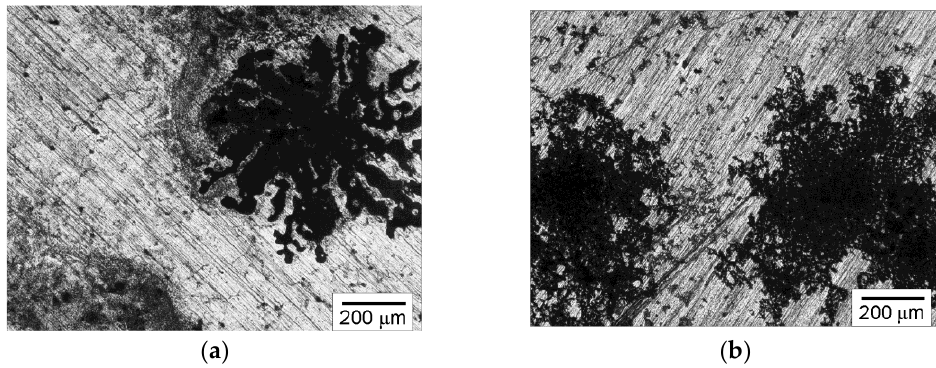
Figure 6. Corrosion centers on non-remelted ( a ) and remelted samples ( b ), light microscope.